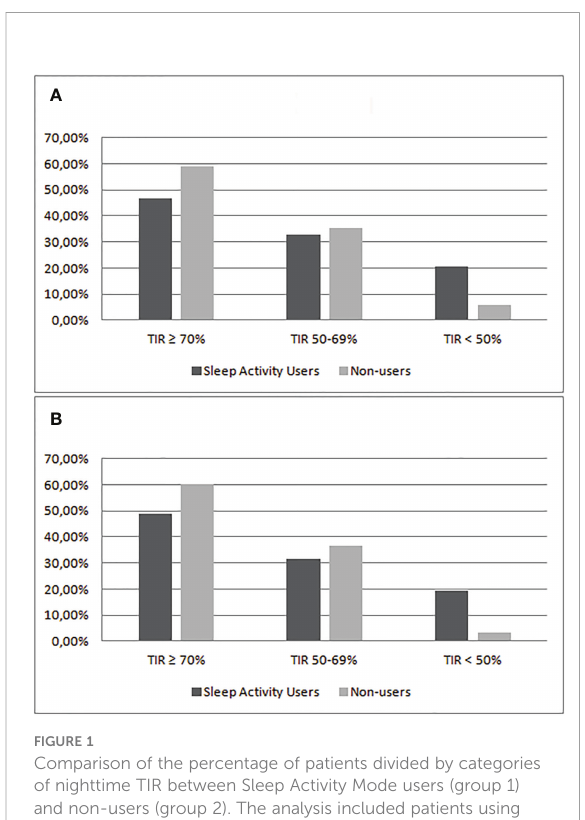
FIGURE 1 Comparison of the percentage of patients divided by categories of nighttime TIR between Sleep Activity Mode users (group 1) and non-users (group 2). The analysis included patients using sensor and automatic mode ≥ 80% (A) or ≥ 90% (B) .